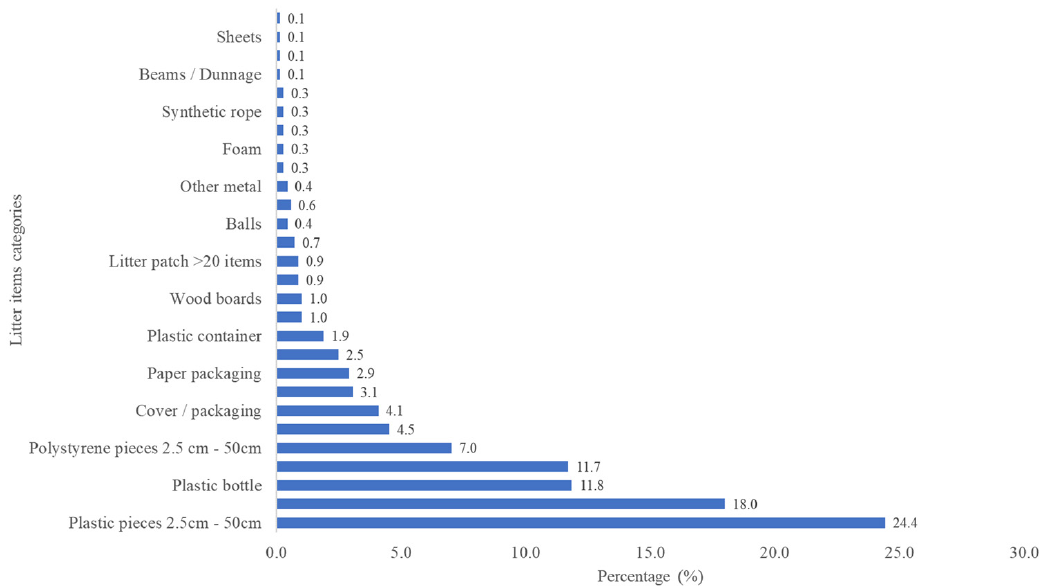
Figure 9. Percentage of recorded litter item categories on observed rivers.